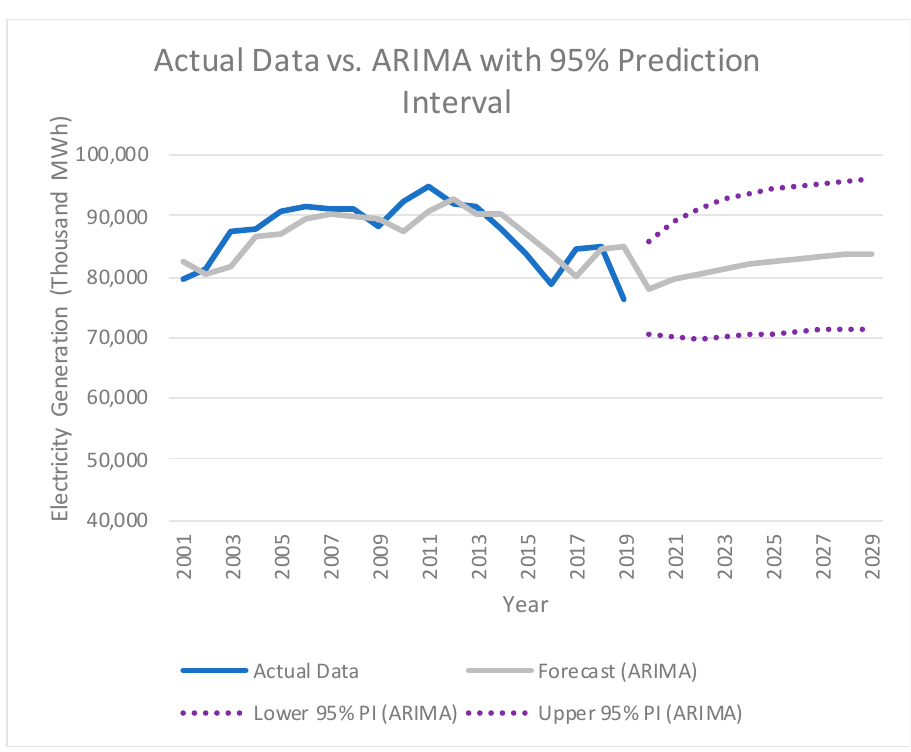
Figure 5. Actual Data vs. ARIMA with 95% Prediction Interval. To further demonstrate the difference between the two models, prediction interval width is plotted for the forecast horizon in Figure 6.